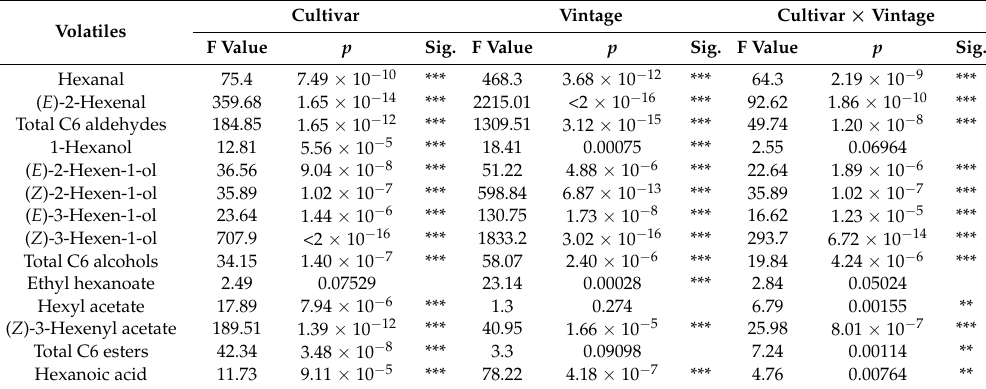
Table 1. Two-way ANOVA analysis on the concentration of C6 volatiles in seven table grape cultivars during berry